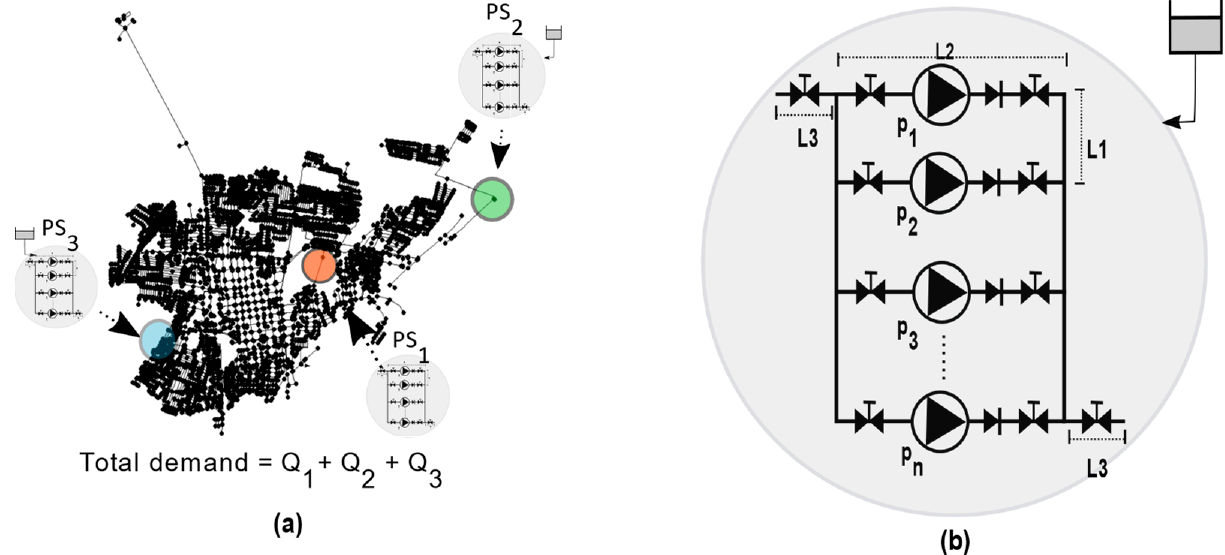
Figure 4. Case study. ( a ) Curicó water distribution network; ( b ) modular design for PS i.